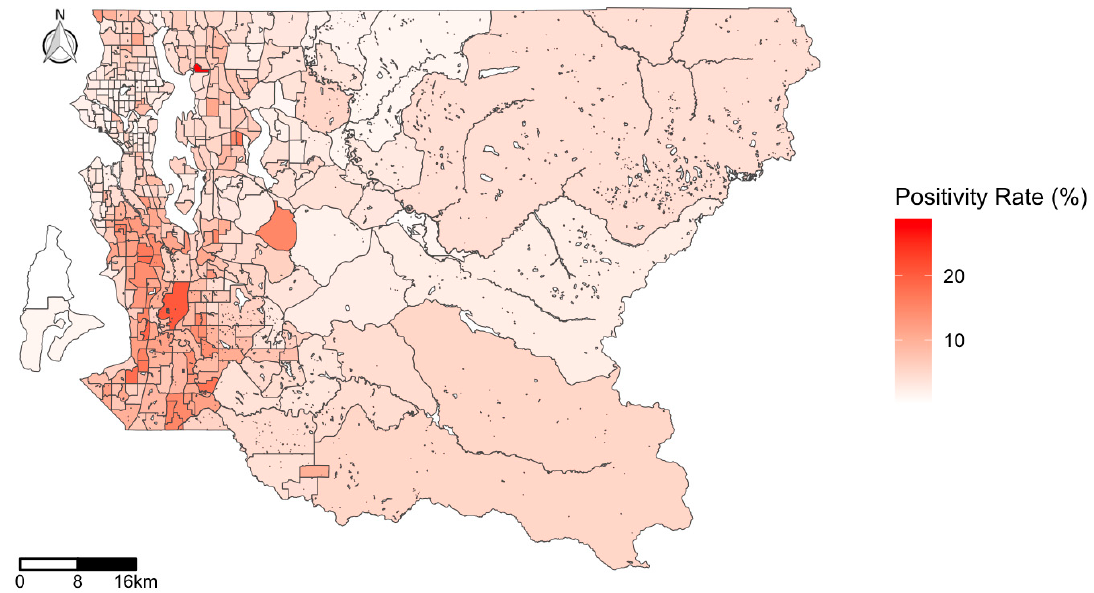
Figure 1. Map of COVID-19 test positivity rate (positives per test) by census tract in King County, WA, USA.